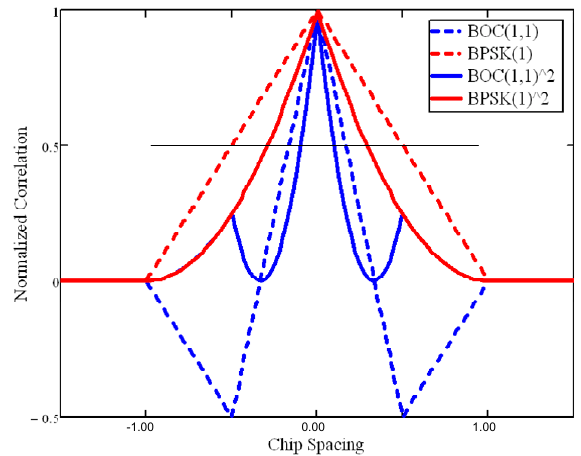
Figure 6. Infinite Bandwidth BPSK (1) and BOC(1,1) − n = 2 − Coherent and Non-Coherent Normalized Correlation Functions.